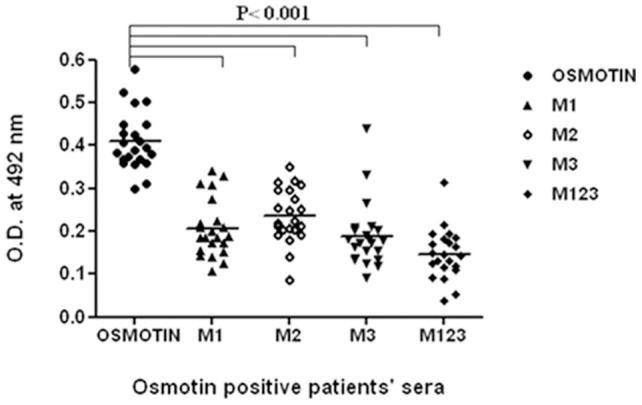
IgE affinity of osmotin, M1, M2, M3, M123 with food allergic patients' sera (n = 22).Specific IgE values against the respective proteins in patients' sera by ELISA. Specific IgE values ≥3 times of control were taken as cutoff for the positive results. (─) median value. Statistical difference in IgE binding among osmotin and the mutants is p<0.001 was considered statistically significant.